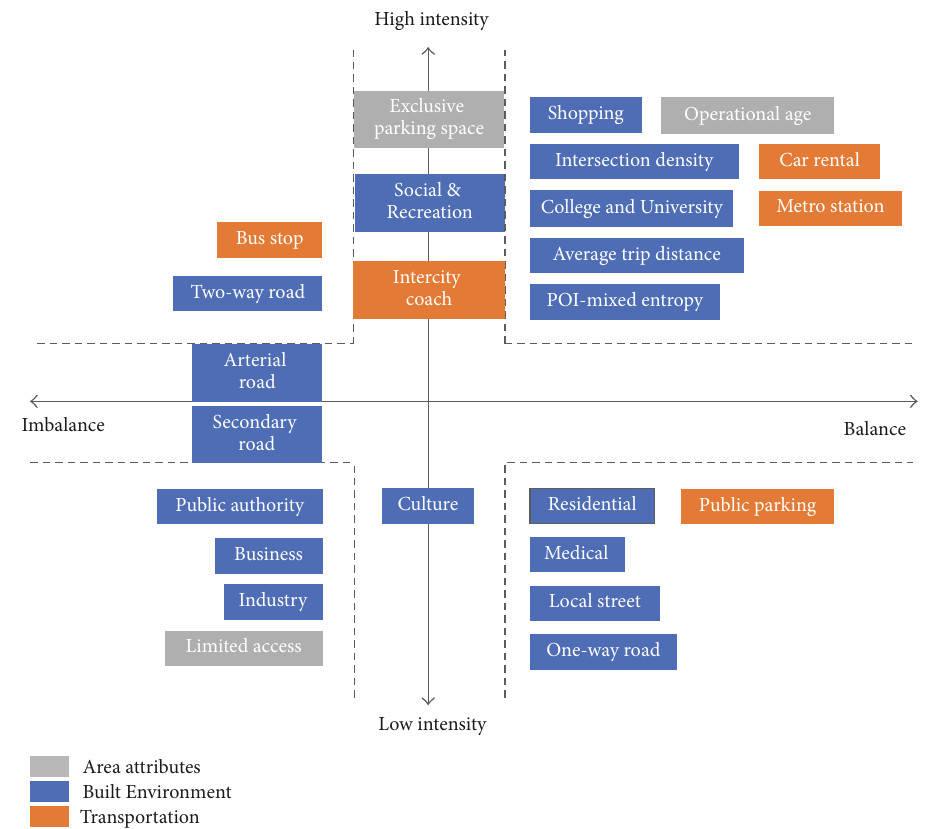
Figure 6: Influence diagram of statistically significant independent